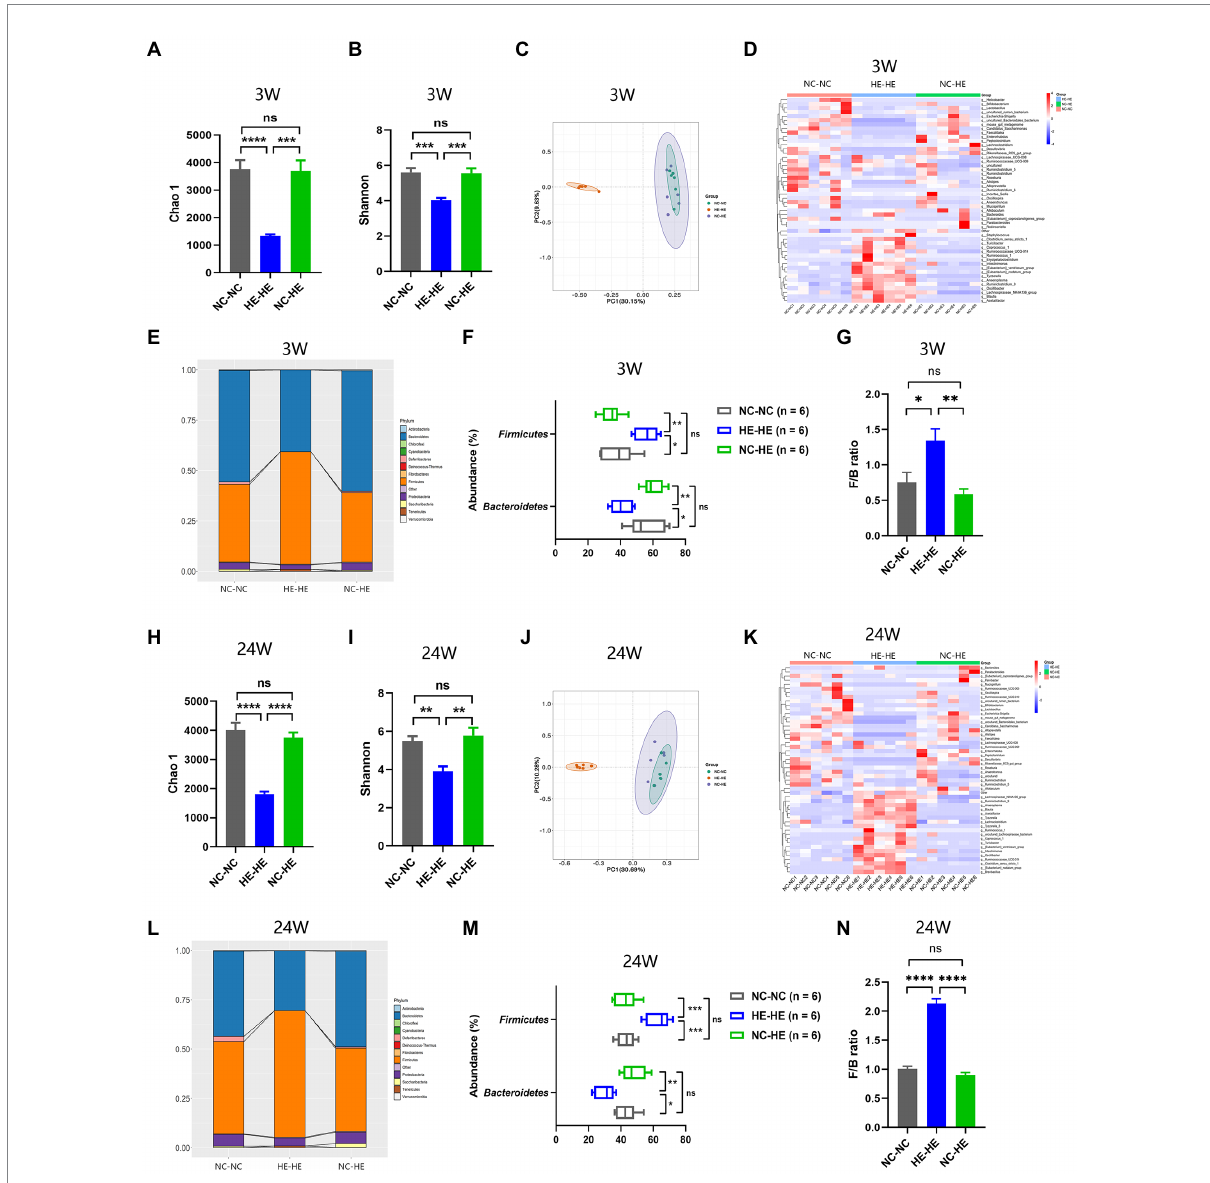
FIGURE 2 Gut microbiota composition analysis in 3-week-old (A–G) and 24-week-old (H–N) NC-NC, HE-HE, and NC-HE mice. (A,H) Chao 1 index, (B,I) Shannon index, and (C,J) PCoA plots of gut microbiota. (D,K) Heatmap of top 50 differentiated genera. (E,L) Phylum distribution. (F,M) Abundance of Firmicutes and Bacteroidetes . (G,N) Relative Firmicutes / Bacteroidetes (F/B) ratio. Error bars represent SEM. Significance determined by one-way ANOVA. * p < 0.05; ** p < 0.01; *** p < 0.001; **** p < 0.0001; ns, not